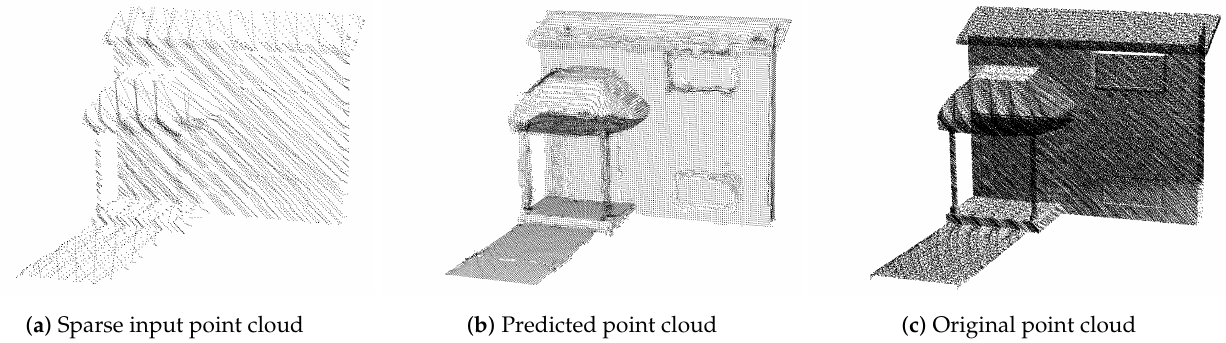
Version November 18, 2021 submitted to Remote Sens.